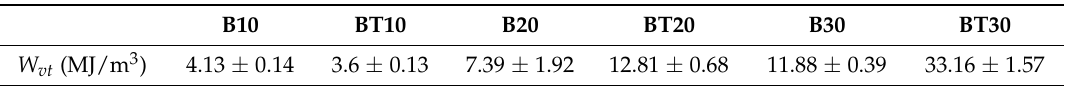
Figure 12. Comparison of energy absorbed per unit volume up to 50% strain, W vt , for CAD-based and TPMS-based samples (three replicate specimens, means and standard deviations). Table 3. The value of W vt for CAD-based and TPMS-based samples, given as means ± standard deviations (three replicate specimens).